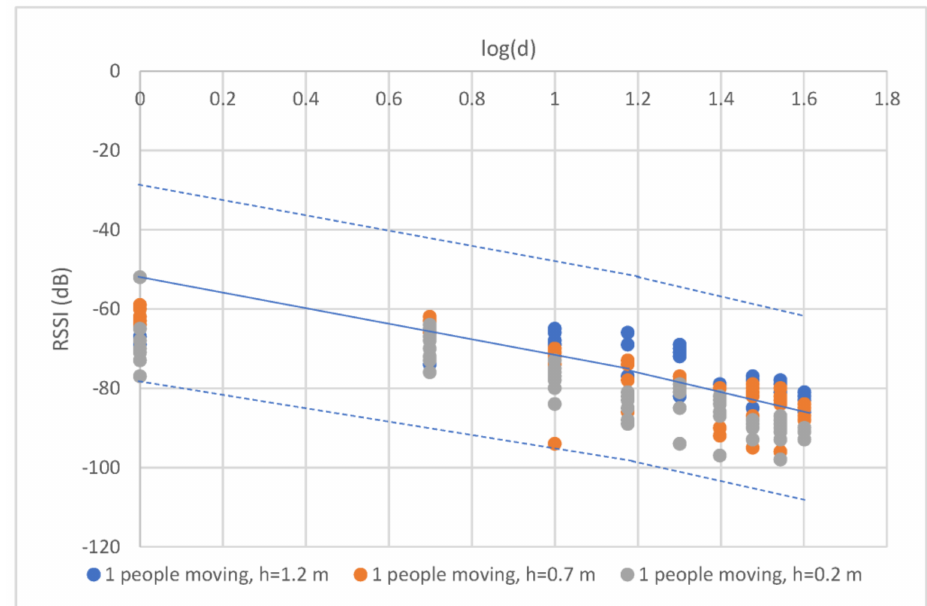
Figure 11. FLR curves for one person moving with membership level 0.0.